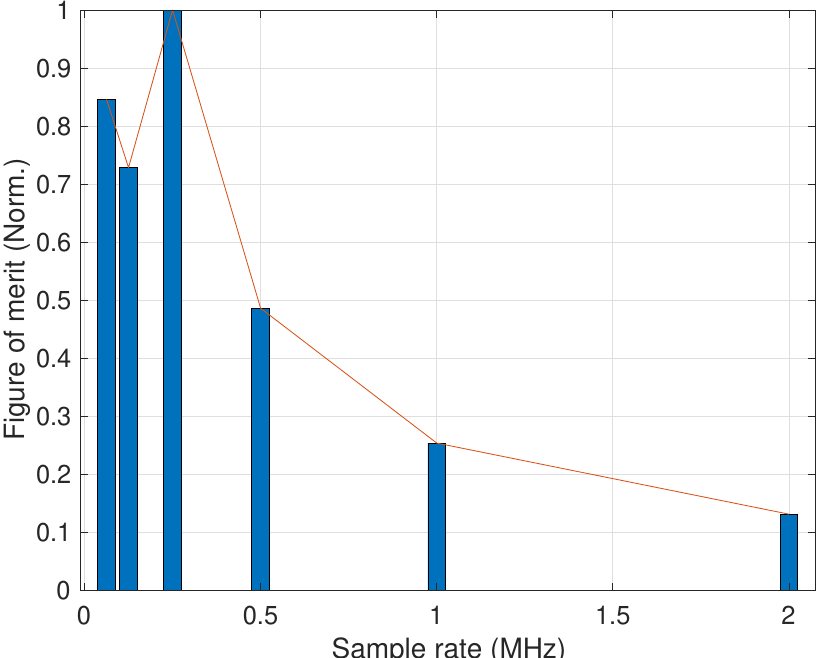
Figure 10. Normalized figure-of-merit versus sensor